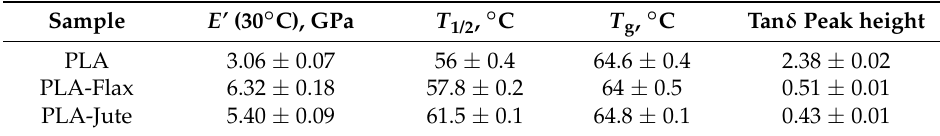
Table 2. Dynamic mechanical properties of the investigated samples.